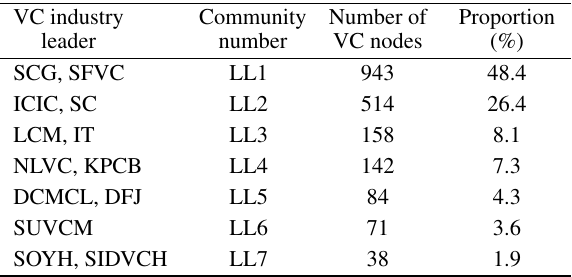
Table 4 Semi-supervised community detection results of LL algorithm.